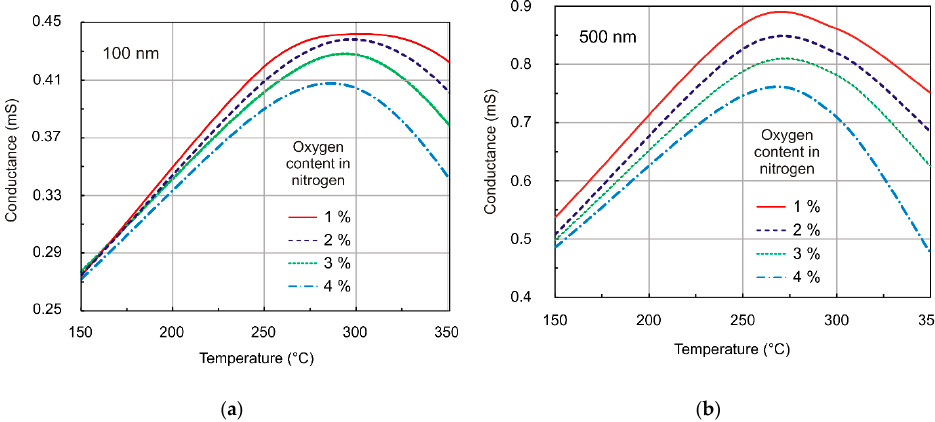
Figure 12. Measured conductance versus temperature of the MS-SnO 2 thin film sensor for different oxygen content in nitrogen (magnetron sputtering deposition rate = 85 nm/min) for layer thickness of ( a ) 100 nm and ( b ) 500 nm.